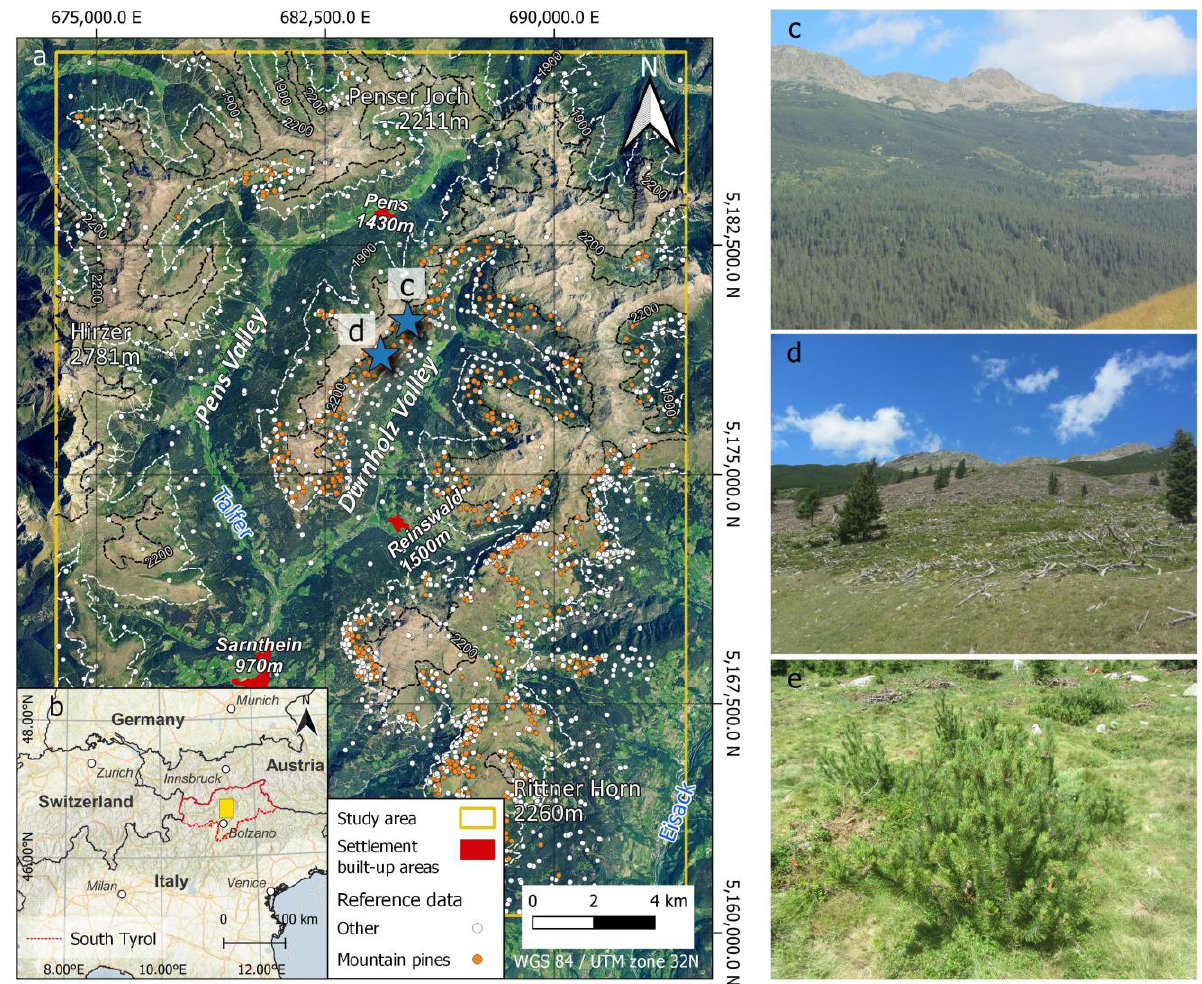
Figure 1. ( a ) Study area in Sarntal Valley with reference data points for mountain pines and other land cover classes. Blue stars indicate the locations of the field photography seen in c , d . Background: Orthophoto 2020 (Autonomous Province of Bolzano); ( b ) location of study area in South Tyrol, Italy. Basemap and Hillshade: OpenStreetMap, SRTM; ( c , d ) mountain pine fields in Durnholz Valley with visible clear-cuts. Pictures were taken during a field visit in July 2021 and ( e ) typical appearance of young, regrowing mountain pine. Picture was taken near location ( d ).